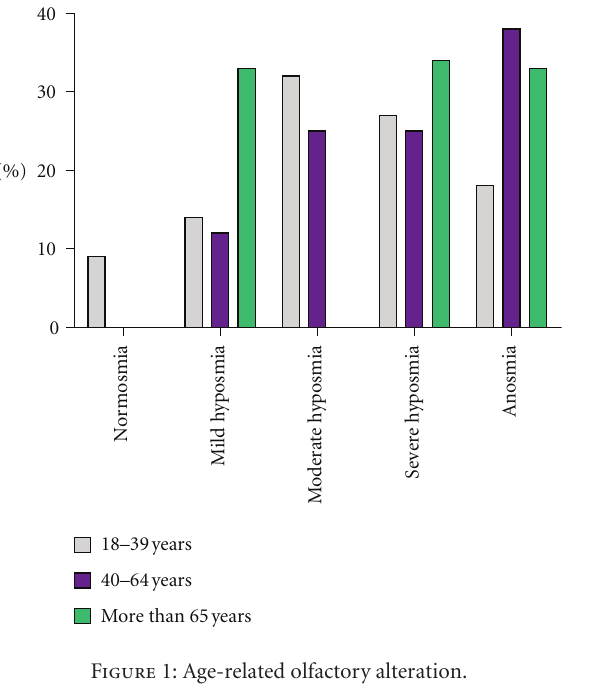
Figure 1: Age-related olfactory alteration.